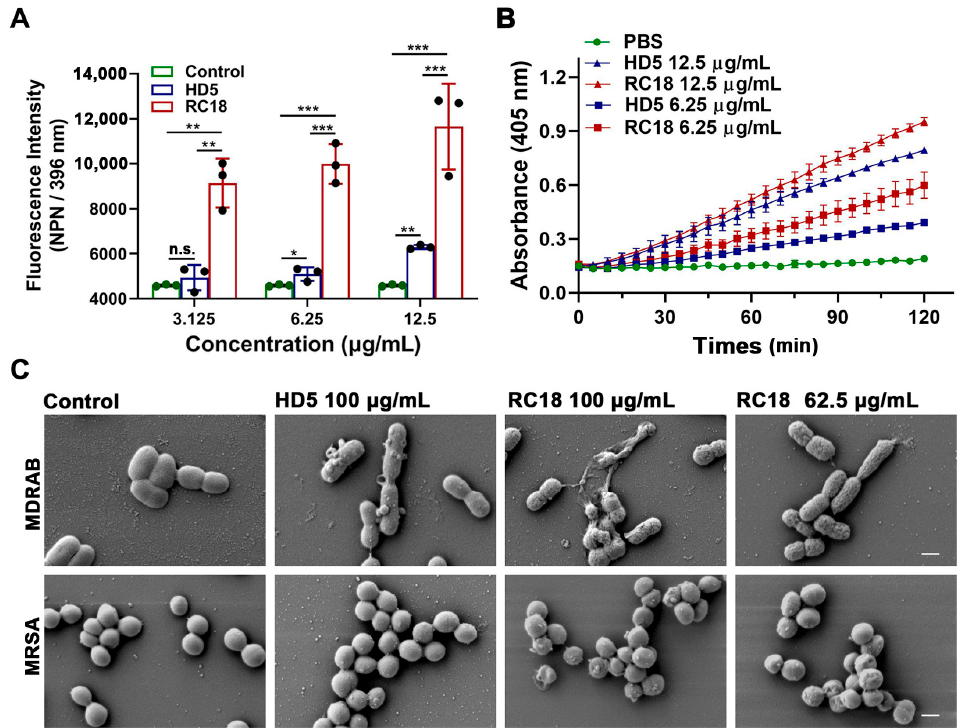
Figure 3. ( A ) Outer membrane infiltration assay. The fluorescence intensity of NPN after